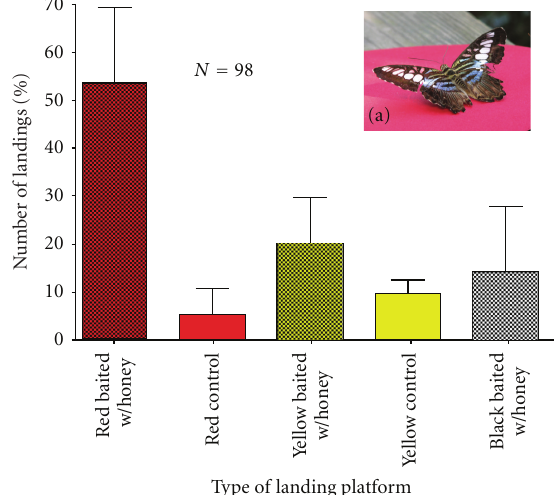
Figure 1: Bioassay I. The Clipper butterflies, Parthenos sylvia (a), showed a strong preference for the red baited landing platforms when o ff ered an array of other choices.